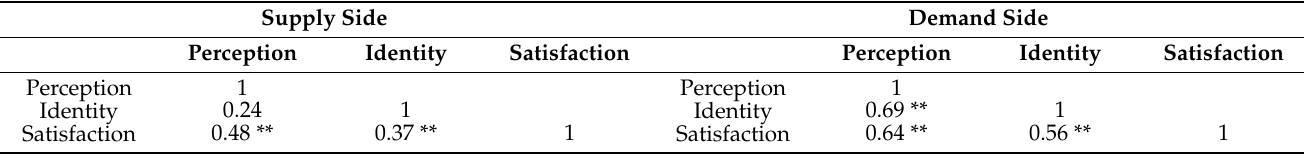
Table 3. Correlation analyses of perception, identity, and